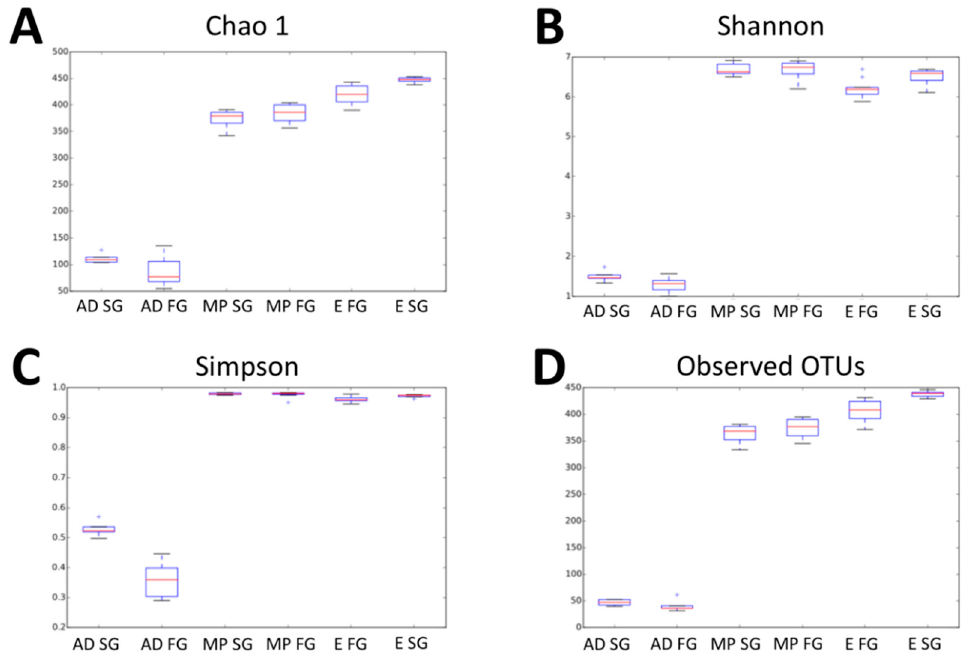
Figure 1. Evaluation of alpha diversity in fast and slow-growing management systems using di ff erent calculation measures. ( A ): Chao 1. ( B ): Shannon. ( C ): Simpson. ( D ): Observed OUTs. AD SG: slow-growing breed at arrival day; AD FG: fast-growing breed at arrival day; MP SG: slow-growing breed at mid-period; MP FG: fast-growing breed at mid-period; E FG: fast-growing breed at the end of the